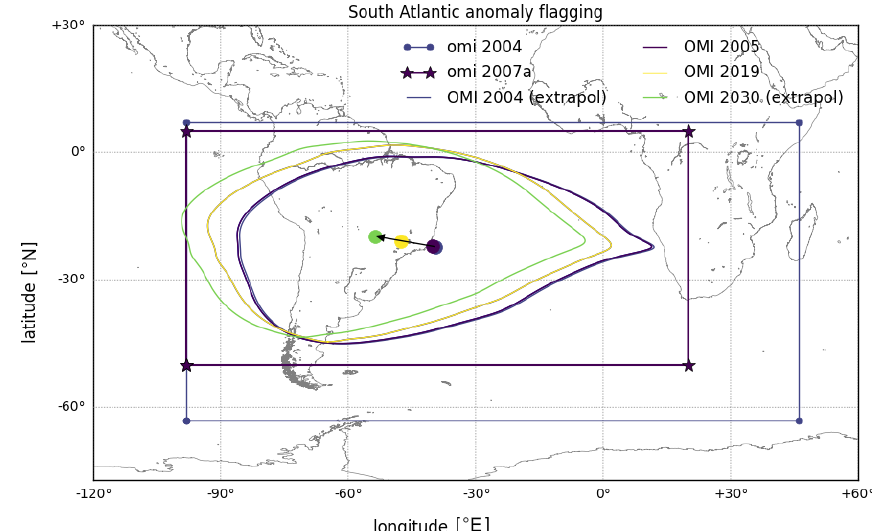
Figure 17. SAA bounding-box limits for collection 3 are shown as the square regions based on the 2004 (light blue) and 2007 (purple) analysis. For collection-4 polygons were derived using 2005 (blue) and 2019 (yellow) data. The centerpoint of the polygon contour is indicated by a dot of the same color and clearly drifts in time. The movement of the centerpoints is used to extrapolate the contours down to 2004 (light blue) and up to 2030